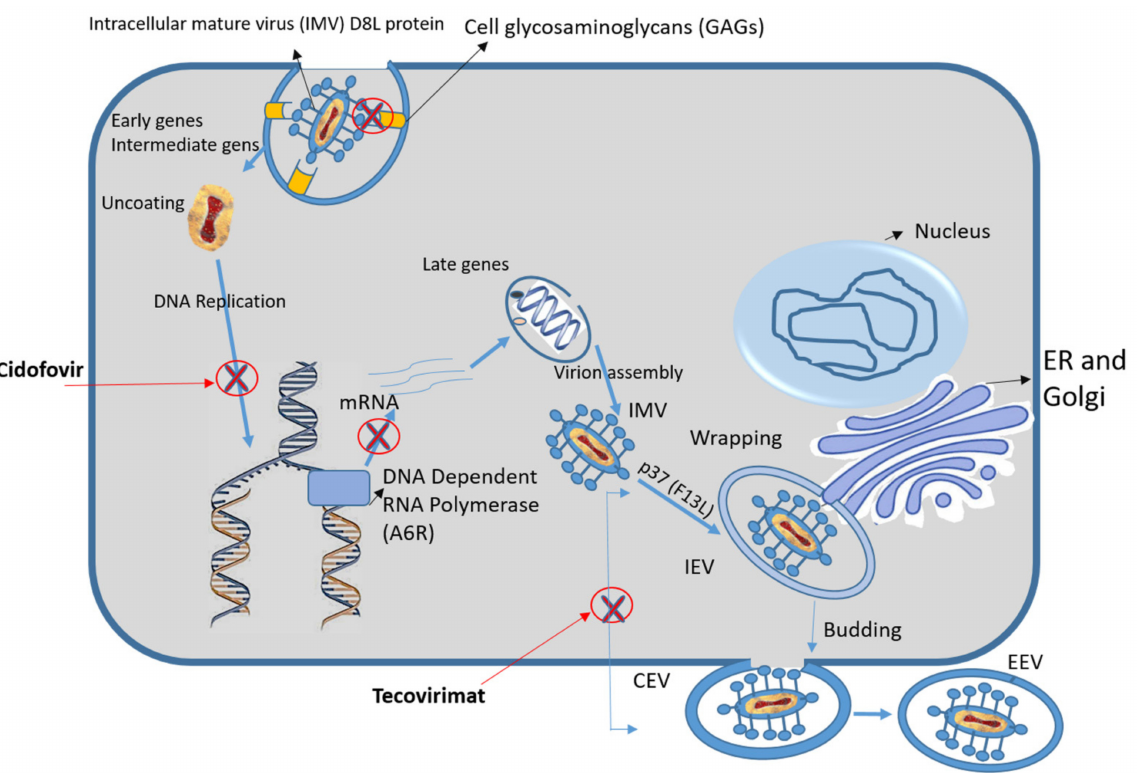
Figure 1. Schematic representation of the MPXV replication cycle, showing the protein targets of antiviral agents (Cidofovir and Tecovirimat) and the studied compound (Fludarabine); the antiviral targets are indicated by red